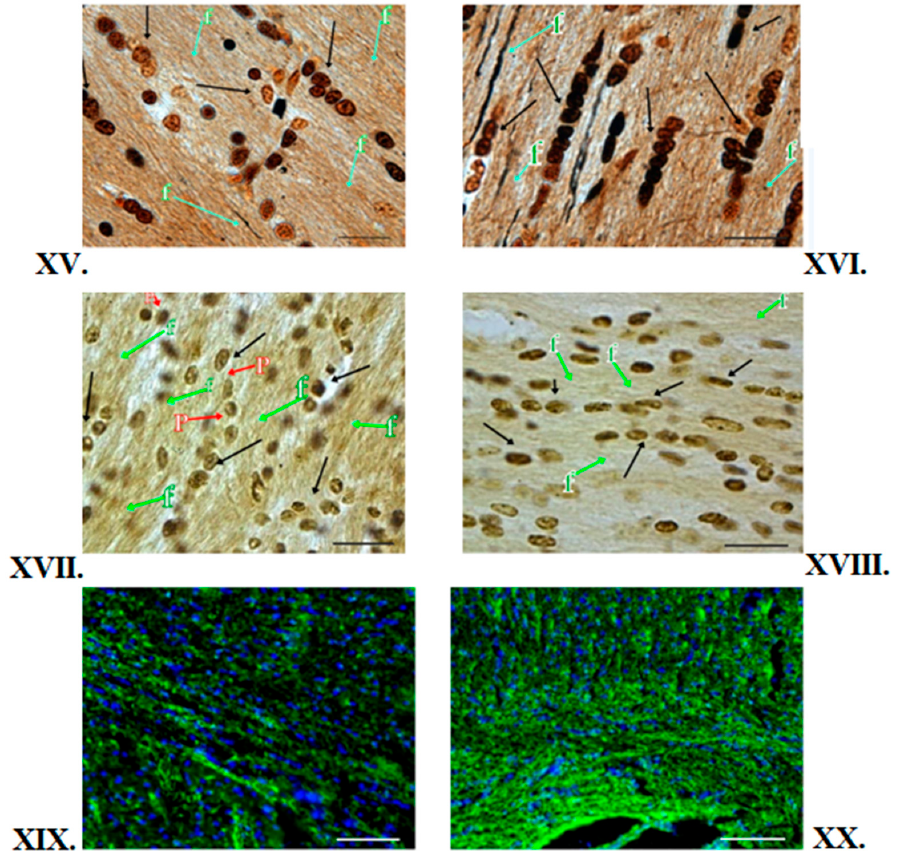
Figure 3. OLGs of the red kangaroo CC. ( XI , XII )—Nissl staining (scale bar 10 µm, ↓ —OLGs);